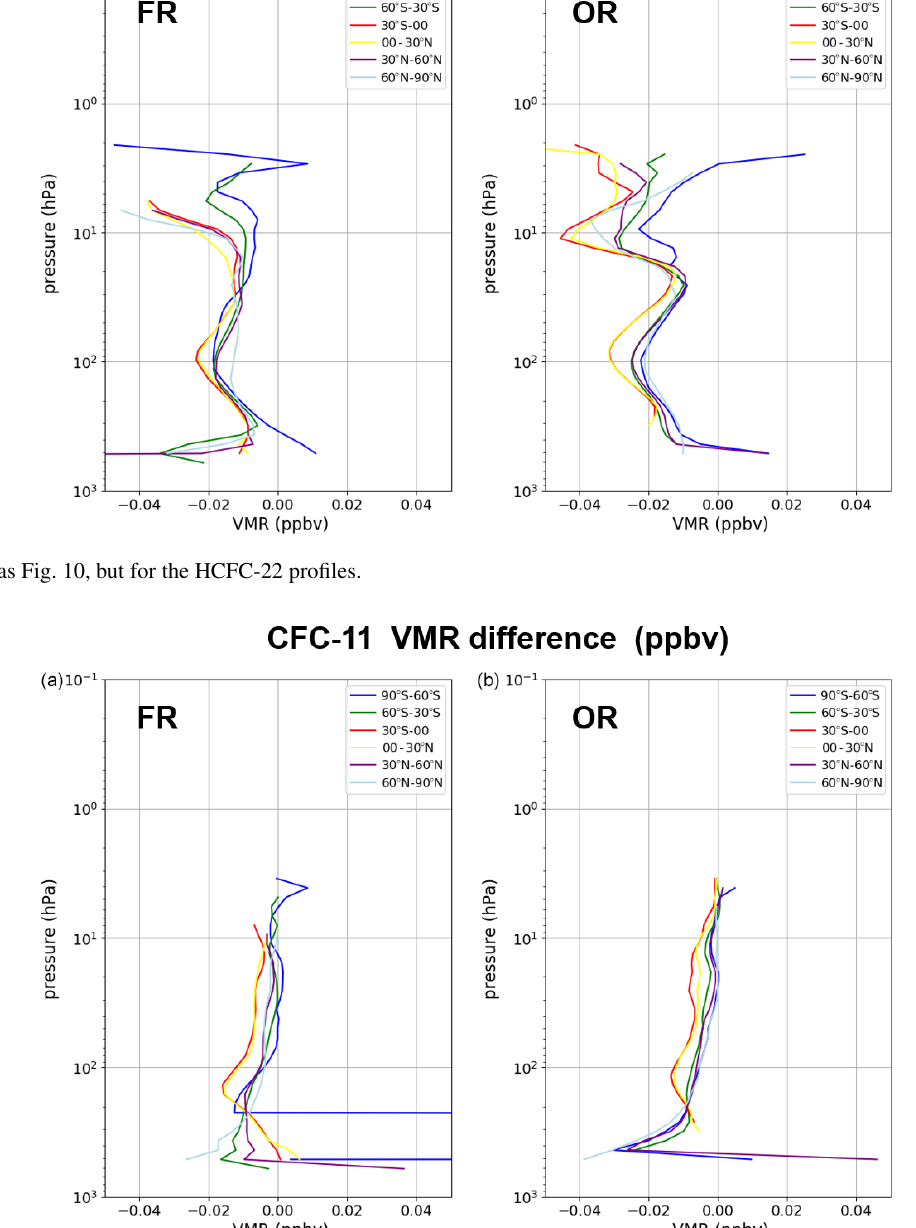
Figure 13. Same as Fig. 10, but for the CFC-11